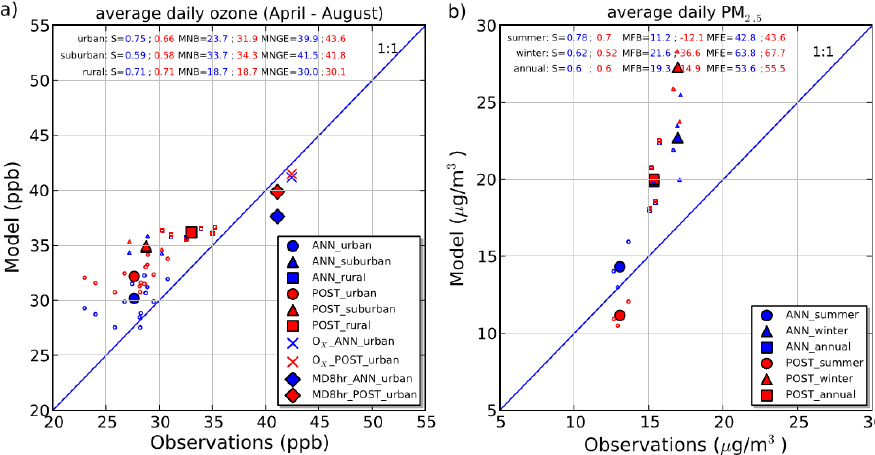
Figure 9. Scatter plots and scores for the sensitivity on the post-processing (temporal analysis and chemical speciation) technique applied on the annual emission totals for ozone and PM 2 . 5